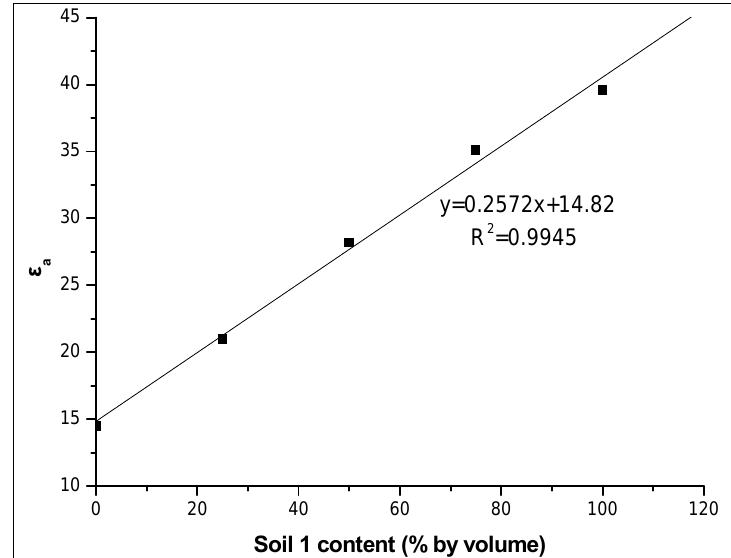
Figure 7. Relationship between the apparent dielectric permittivity ε a and the actual soil water content θ m for five different ratios of the sand ‐ soil mixture studied using the WET sensor.